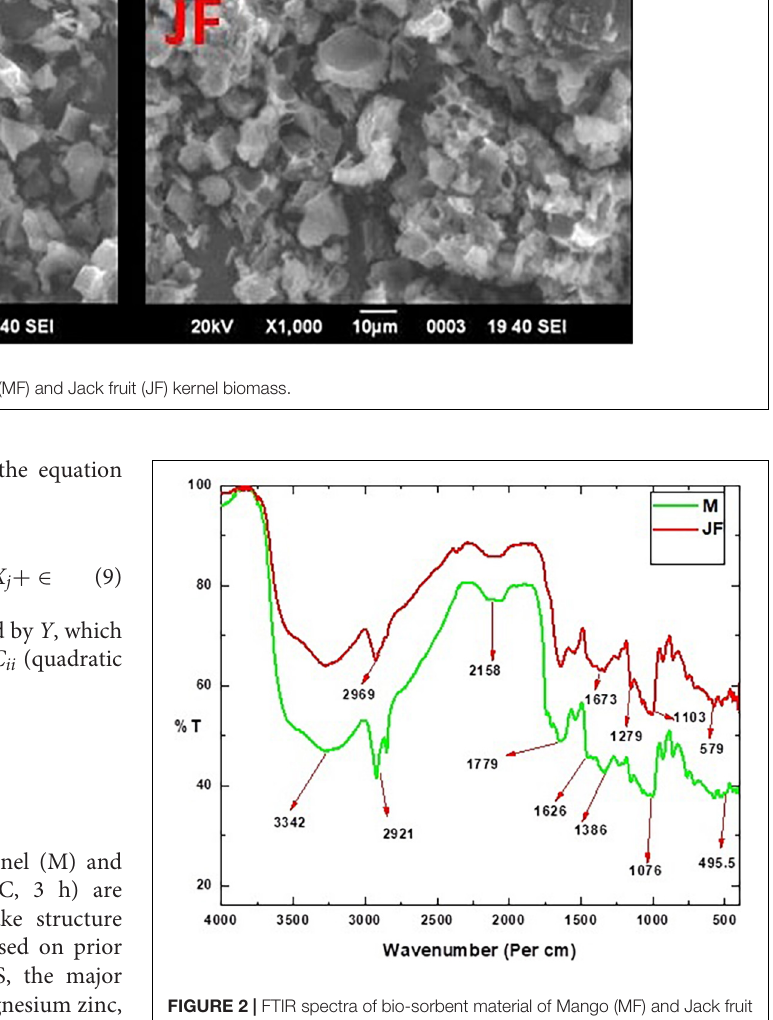
and –C=O (Kumar et al., 2019). The C=C stretch has